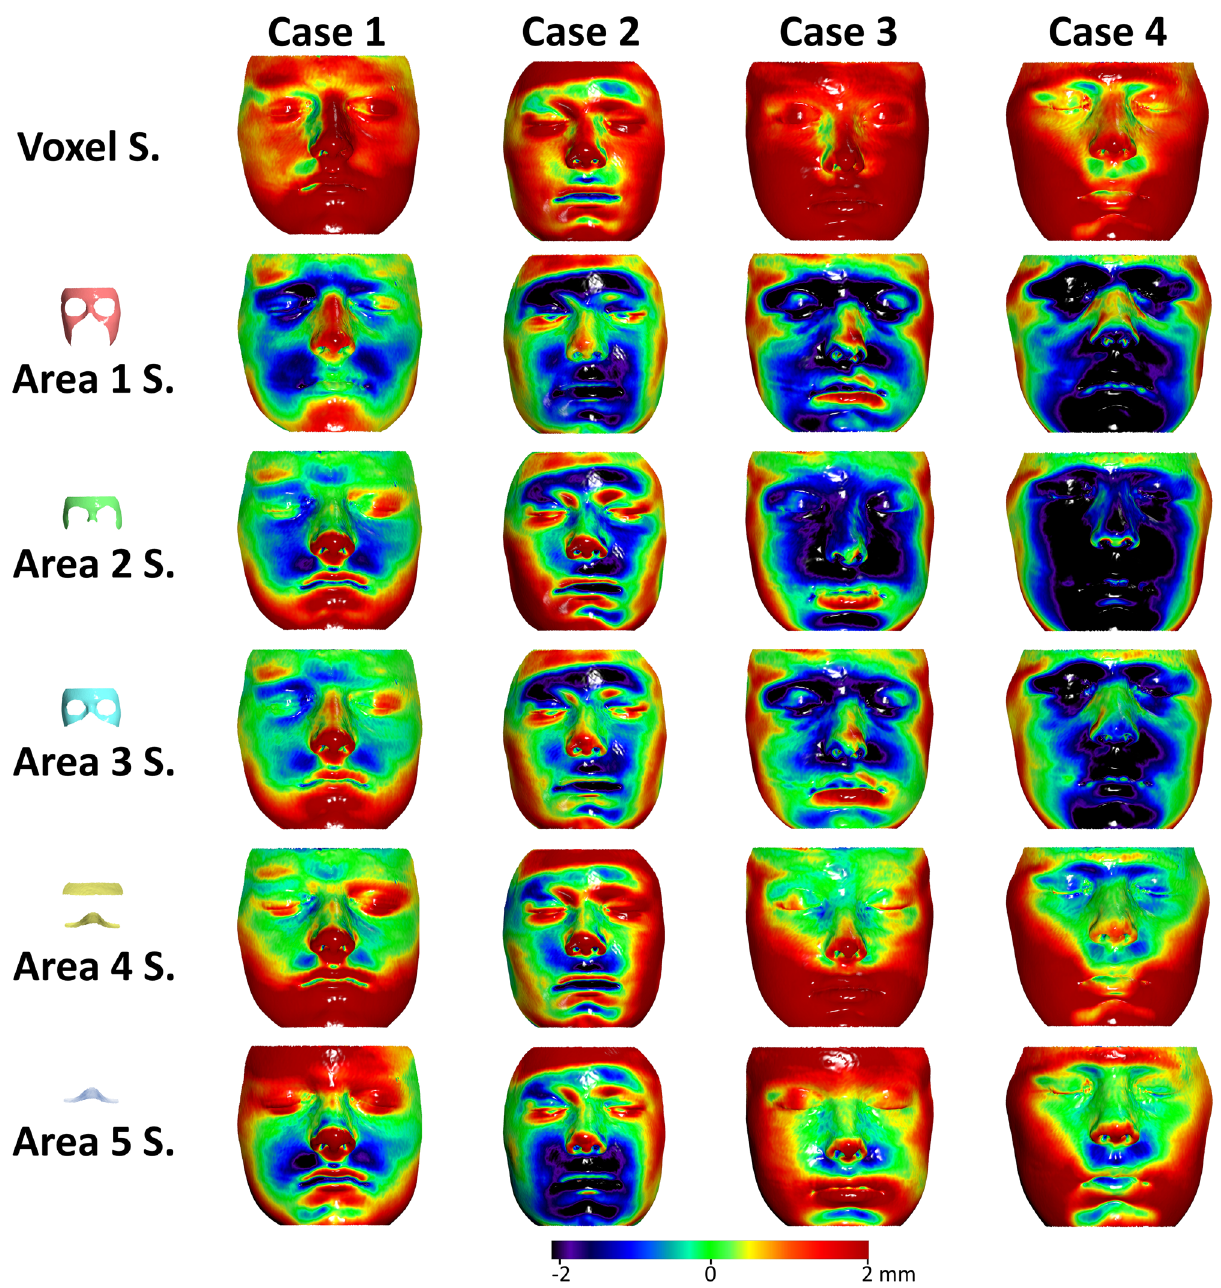
Figure 2. Colour coded distance maps showing T0–T1 facial surface changes of four representative cases, as detected by anterior cranial base voxel-based or five different facial surface-based superimpositions. The T0 facial surface model was used as a reference. S.: Superimposition. All images were generated using Viewbox 4 software (version 4.1.0.1 BETA, http:// www. dhal. com/ viewb oxind ex.